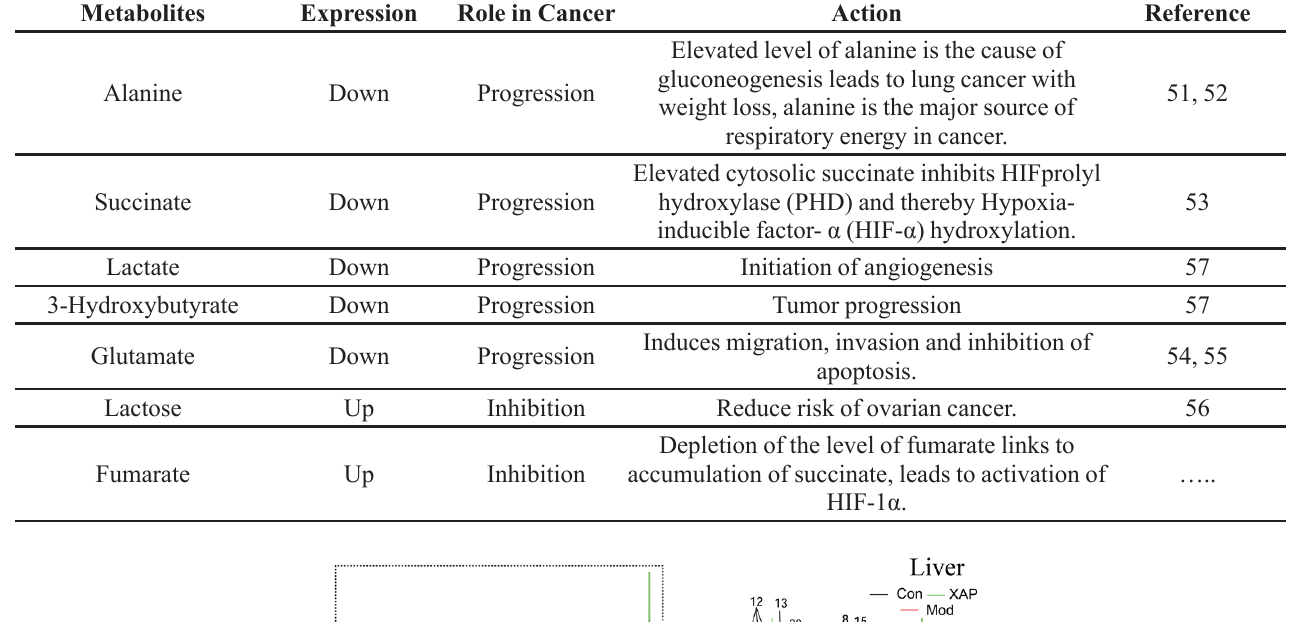
TABLE III - Different level of metabolites: In liver the level of the metabolites, alanine, succinate, glutamate, lactose and fumarate were aberrated significantly. Alanine (Leij-Halfwerk et al., 2000; Tessem et al., 2008), succinate (Yang, Pollard, 2013), glutamate (Fazzari et al., 2015; Willard, Koochekpour, 2013) are related to the cancer progression. Conversely, lactose (Goodman et al., 2002) and fumarate play a pivotal role in the inhibition of cancer progression. However, in kidney, the level of succinate and lactate (Bonuccelli et al., 2010)were notably reduced, besides this the level of 3-Hydroxybutyrate (Bonuccelli et al., 2010) was augmented remarkably, which takes part a major role in tumor